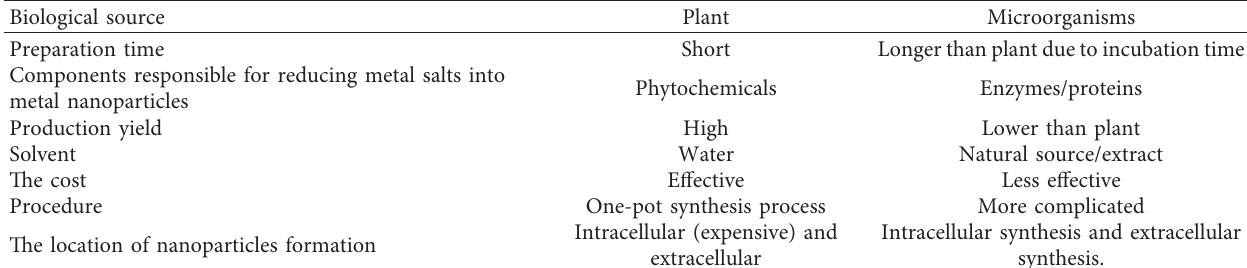
Table 1: Comparison between the plant extract and another microorganisms